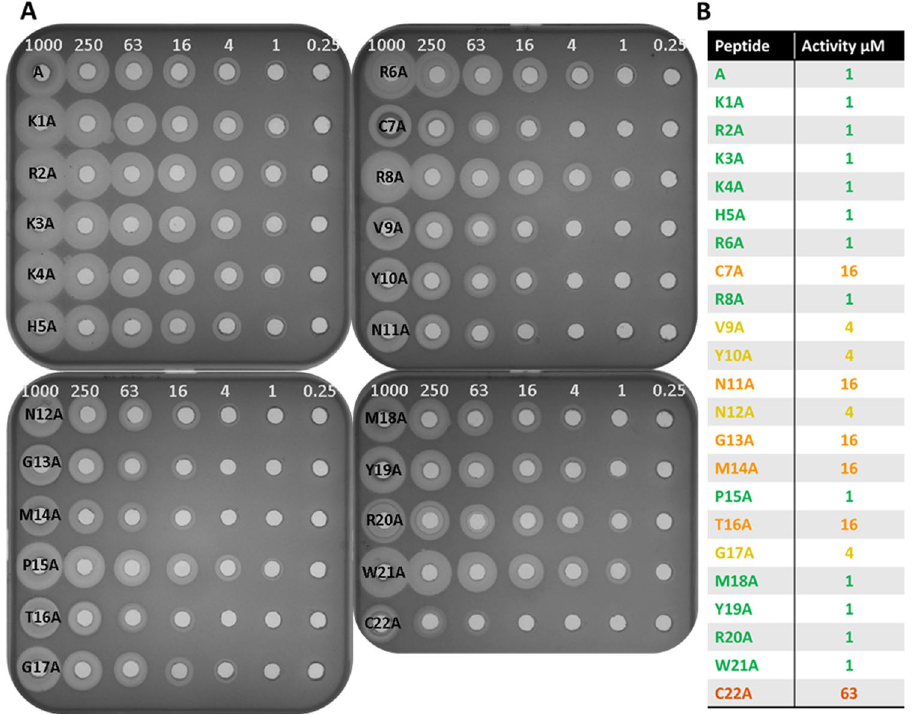
green being most active and red least active.